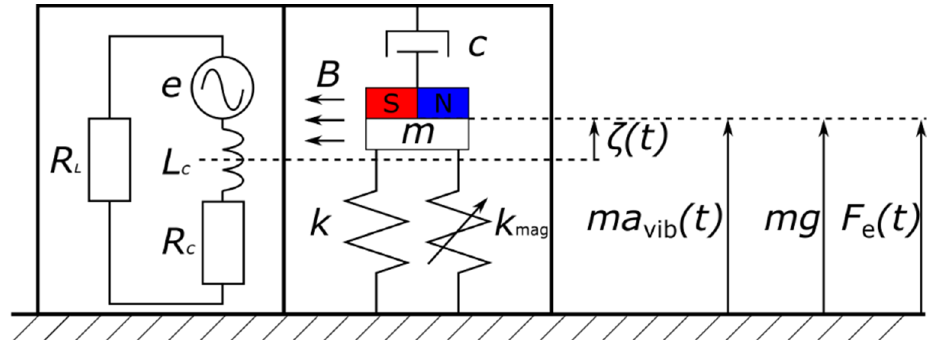
Figure 1. Schematic diagram of the kinematic system of an electromagnetic system for energy harvesting from mechanical vibrations with additional nonlinear magnetic stiffness k mag . B —magnetic flux density, c —damping ratio; e —induced voltage; L c —coil inductance; R c —coil resistance; R L —load resistance.